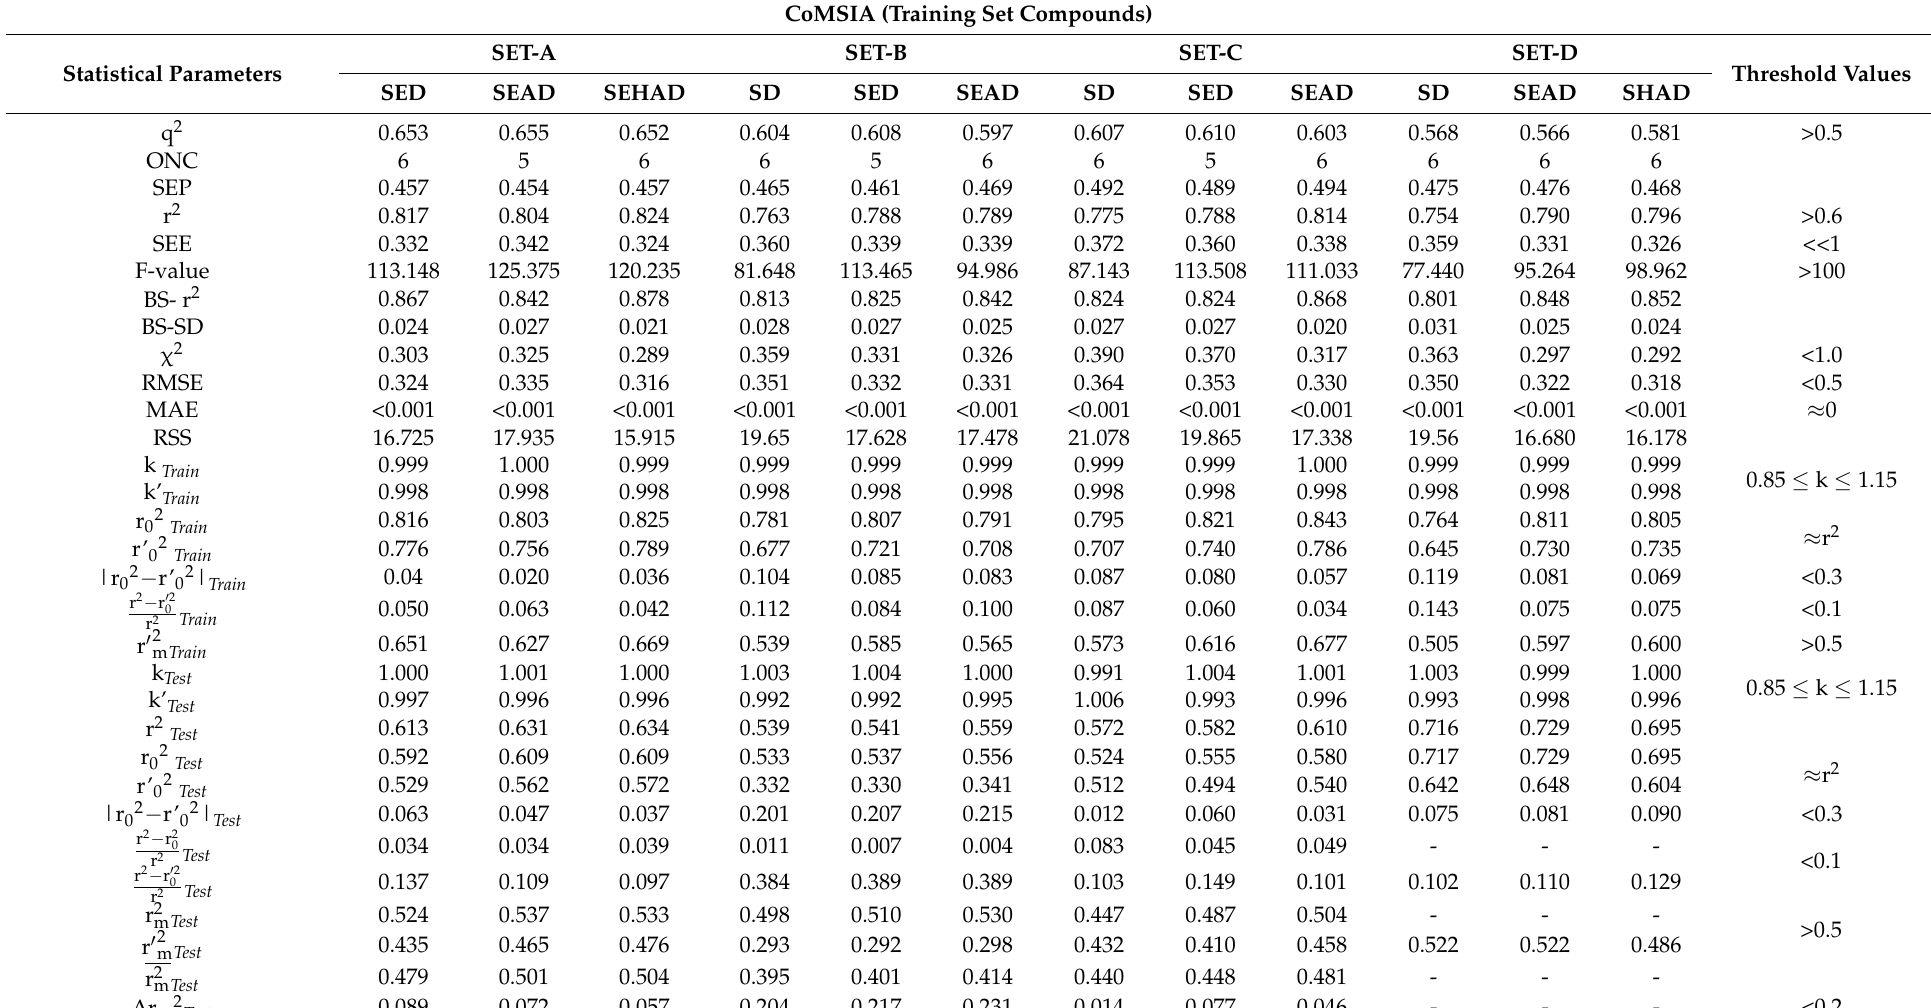
Table 8. Statistics of the CoMSIA models of training set compounds of PI3K γ